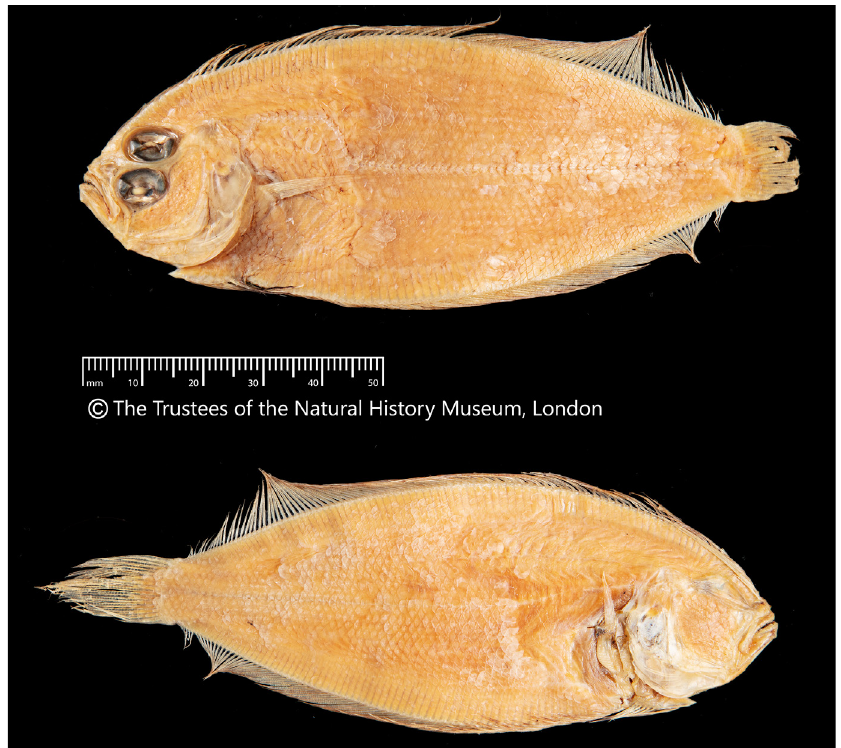
Fig. 8. – Arnoglossus imperialis Rafinesque, 1810, BMNH 1895.7.16.7, one male, 110.8 mm SL, neotype of Rhombus cristatus Lowe, 1839, Madeira. Photographs of preserved specimen taken by L. Goodayle. Above: Ocular side. Below: blind side. Scale indicated 5